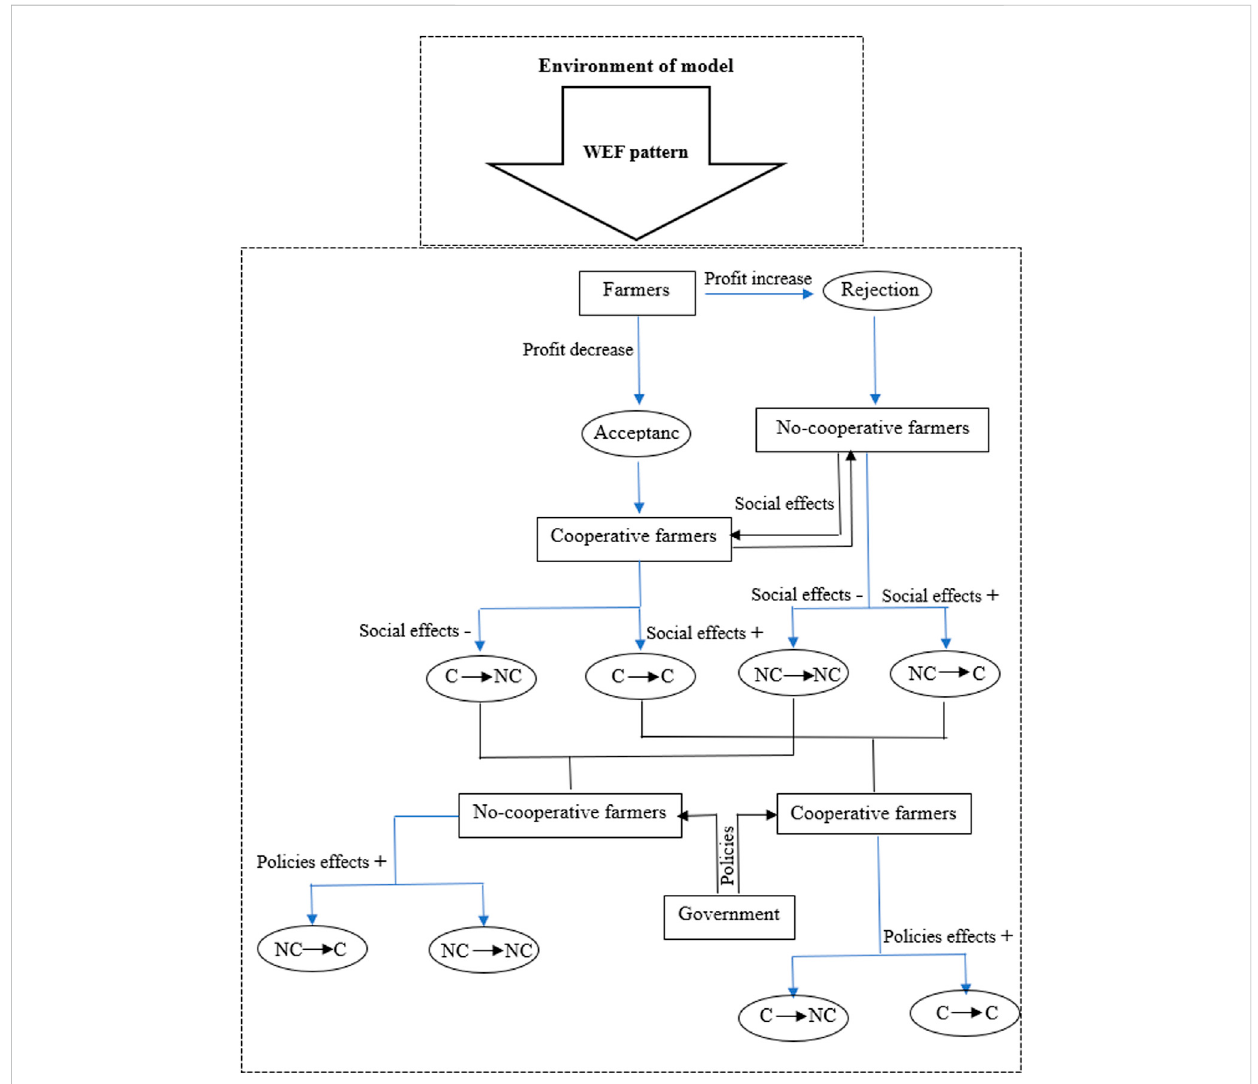
FIGURE 4 ABM formulation structure.